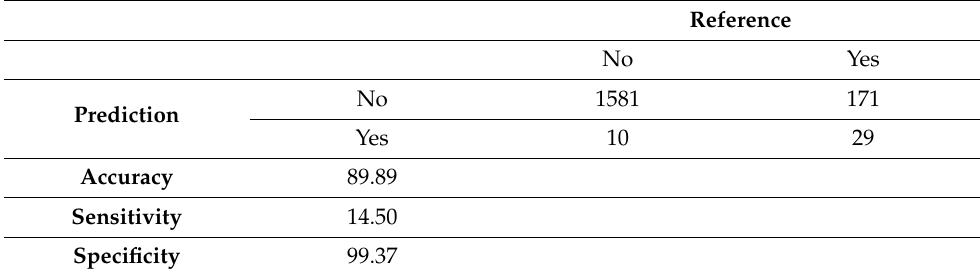
Table 5. Logistic regression model confusion